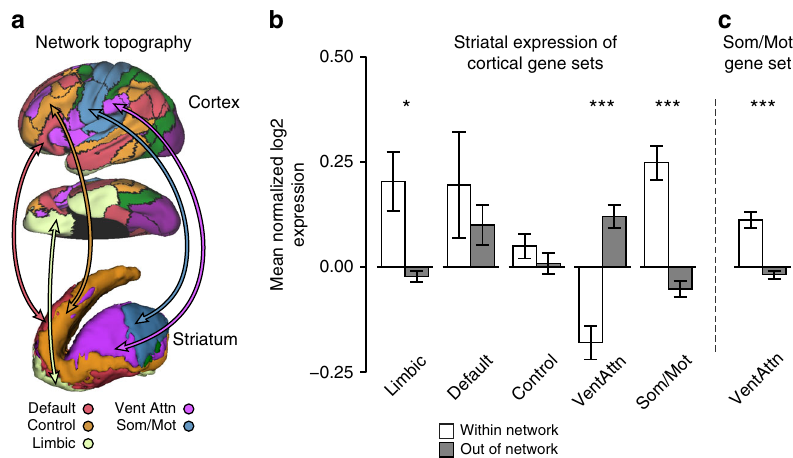
Fig. 3 Network-associated genes de fi ned in the cerebral cortex show network-biased expression in the limbic and somato/motor striatum. a Schematic illustrating the network architecture of cortex (above/middle) and striatum (below), displayed on the lateral and ventral surfaces of the left hemisphere and striatum. b Bar graph displays the gene expression (mean-normalized log2) of network-biased genes de fi ned from cortex within, and out of, the corresponding striatal network territories using all six AHBA donors. Striatal tissue samples were not available for the dorsal attention and visual networks. Expression was greater for out of network, than within network, genes for ventral attention striatum. Error bars re fl ect ± 1 SEM. c Ventral attention aspects of striatum, relative to the rest of the striatum, displayed signi fi cantly greater expression of the somato/motor cortical gene set. * p ≤ 0.05, ** p ≤ 0.01, *** p ≤